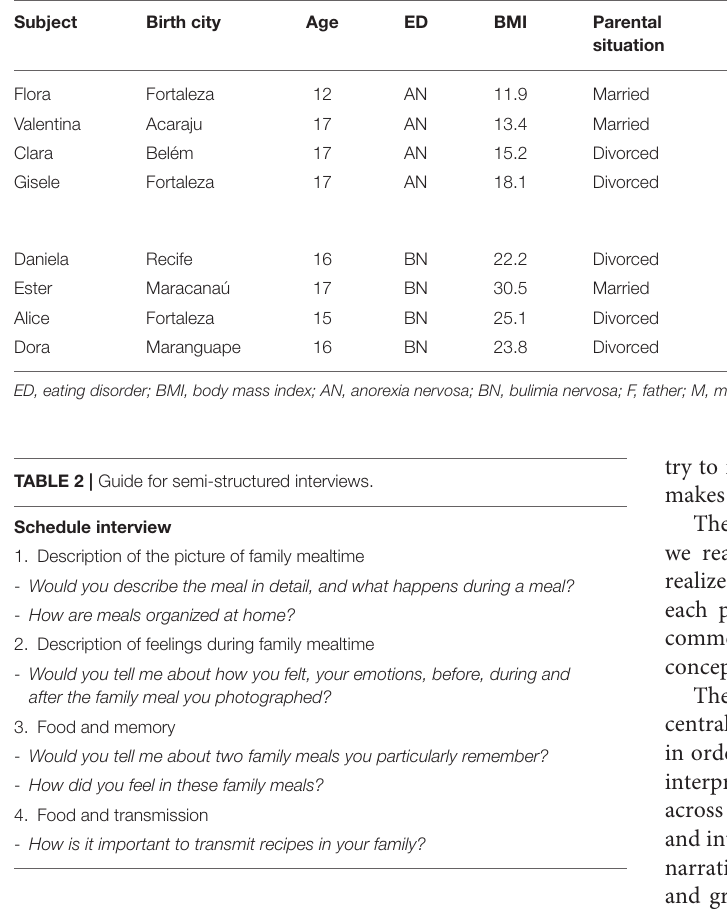
TABLE 1 | Participants’ characteristics.